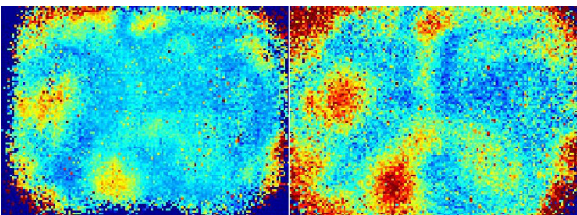
Figure 8. Superimposition of the image residuals (L2 norm). Left – measurement task described in the paper, right – measurement task from different project. Scale: 0–1 µm.